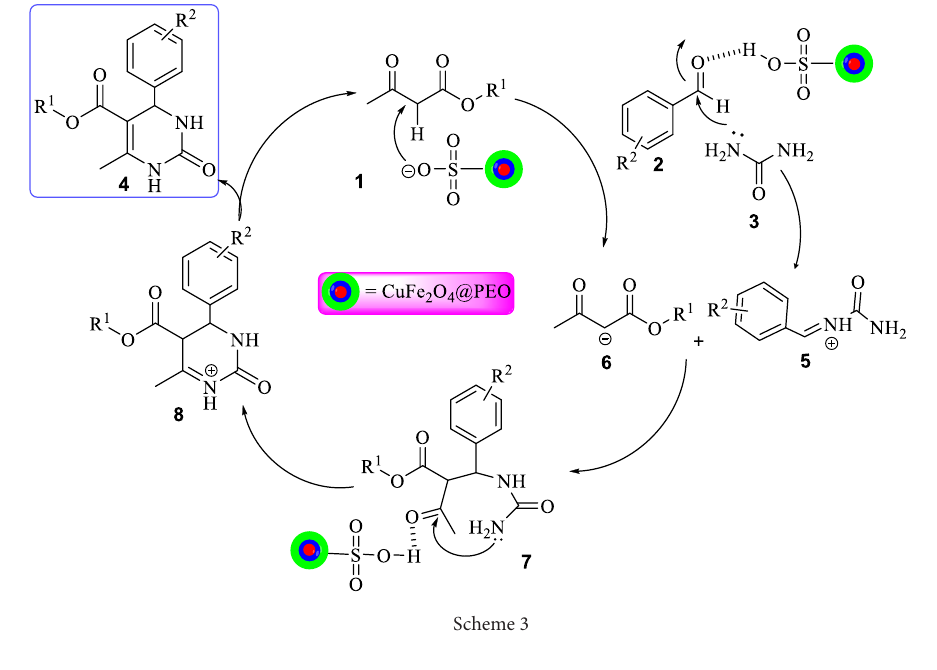
O @PEO-SO H nanocatalyst in the synthesis of 2 4 3